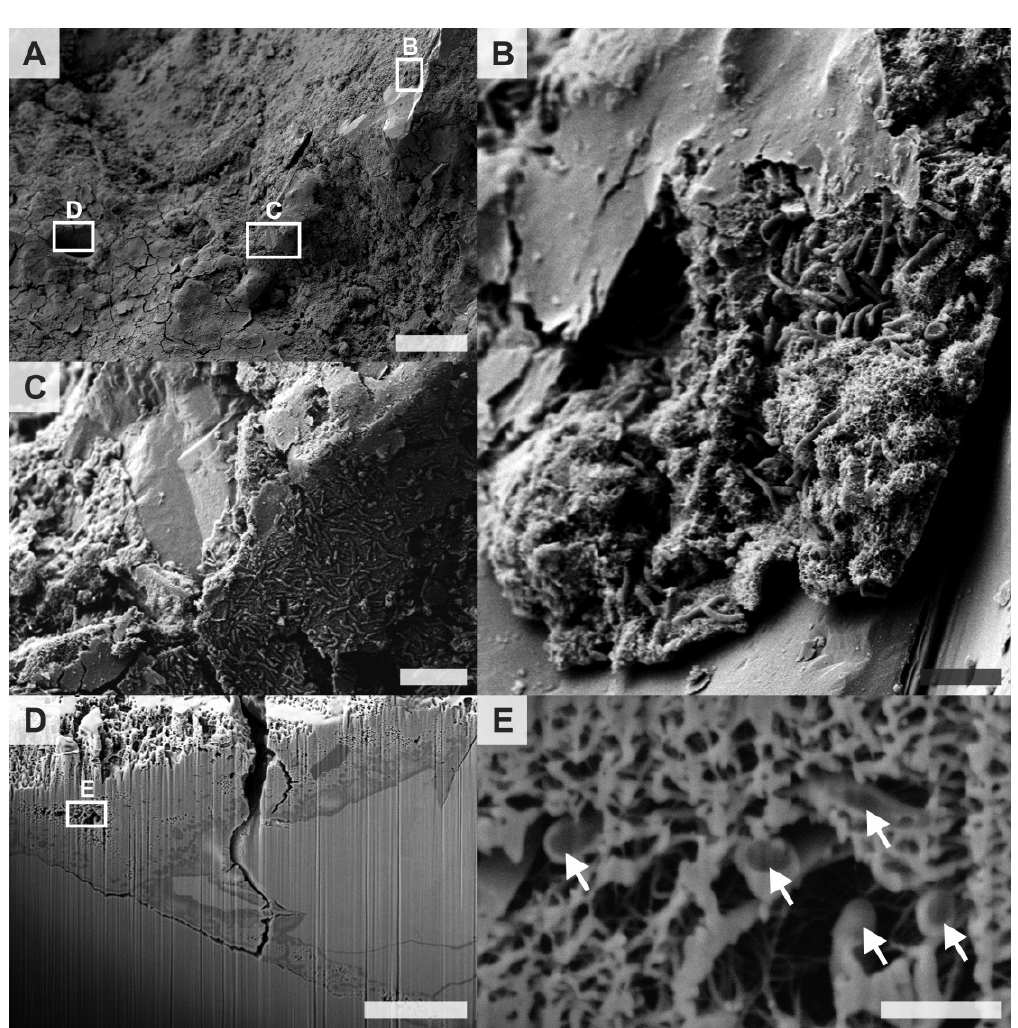
Figure 6. FE-SEM SE micrographs of: ( A ) an overview of the surface of a bacterially-colonized, weathered pyrrhotite grain with areas selected for higher magnification imaging; ( B ) a bacterially-colonized layer of porous schwertmannite and adjacent pyrrhotite surface exhibiting no direct bacterial attachment; ( C ) a mineralised biofilm surrounded by porous schwertmannite with non-porous crust present at the top of the image; ( D ) three different layers of iron oxides exposed by the focused ion beam (FIB) cut; and ( E ) mineralized bacteria (arrows) within the micrometer-scale porous structure located approximately 5 µm below the outer margin of the schwertmannite layer. Scale bars equal 50 µm, 5 µm, 2 µm, 5 µm and 0.5 µm,